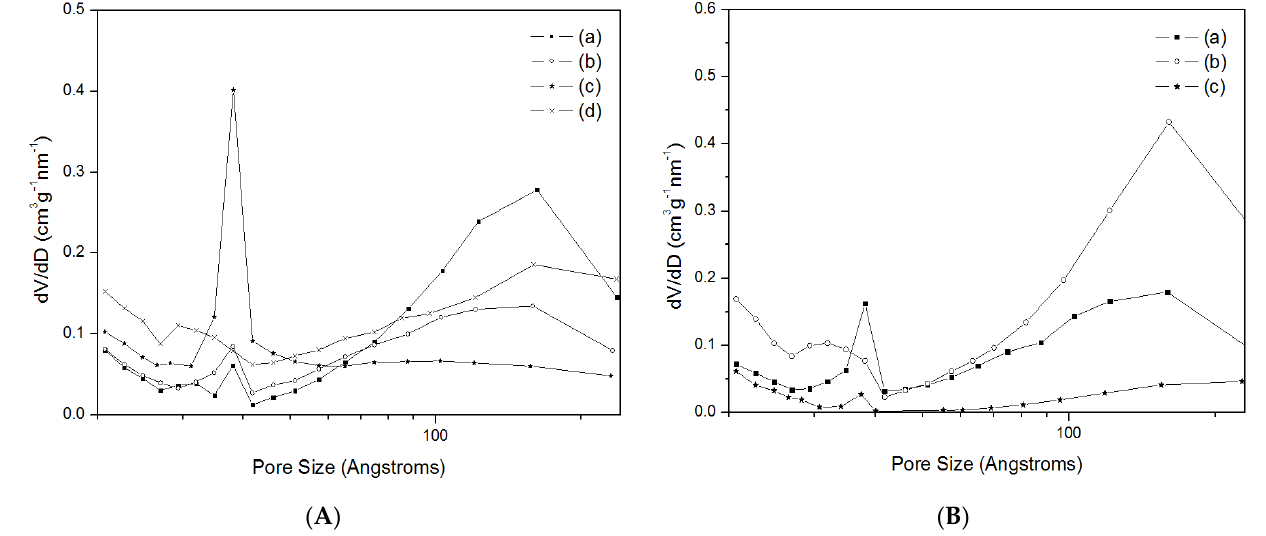
Figure 4. ( A ) Pore size distribution of (a) Na ‐ SSZ ‐ 13 ‐ meso ‐ 0.2, (b) Na ‐ SSZ ‐ 13 ‐ meso ‐ 0.4, (c) Na ‐ SSZ ‐ 13 ‐ meso ‐ 0.6, and (d) Na ‐ SSZ ‐ 13 ‐ meso ‐ 0.8; and ( B ) (a) H ‐ SSZ ‐ 13 ‐ meso ‐ 0.2, (b) H ‐ SSZ ‐ 13 ‐ meso ‐ 0.4, and (c) H ‐ SSZ ‐ 13 ‐ meso ‐ 0.6. X ‐ axis scale is Log 10.